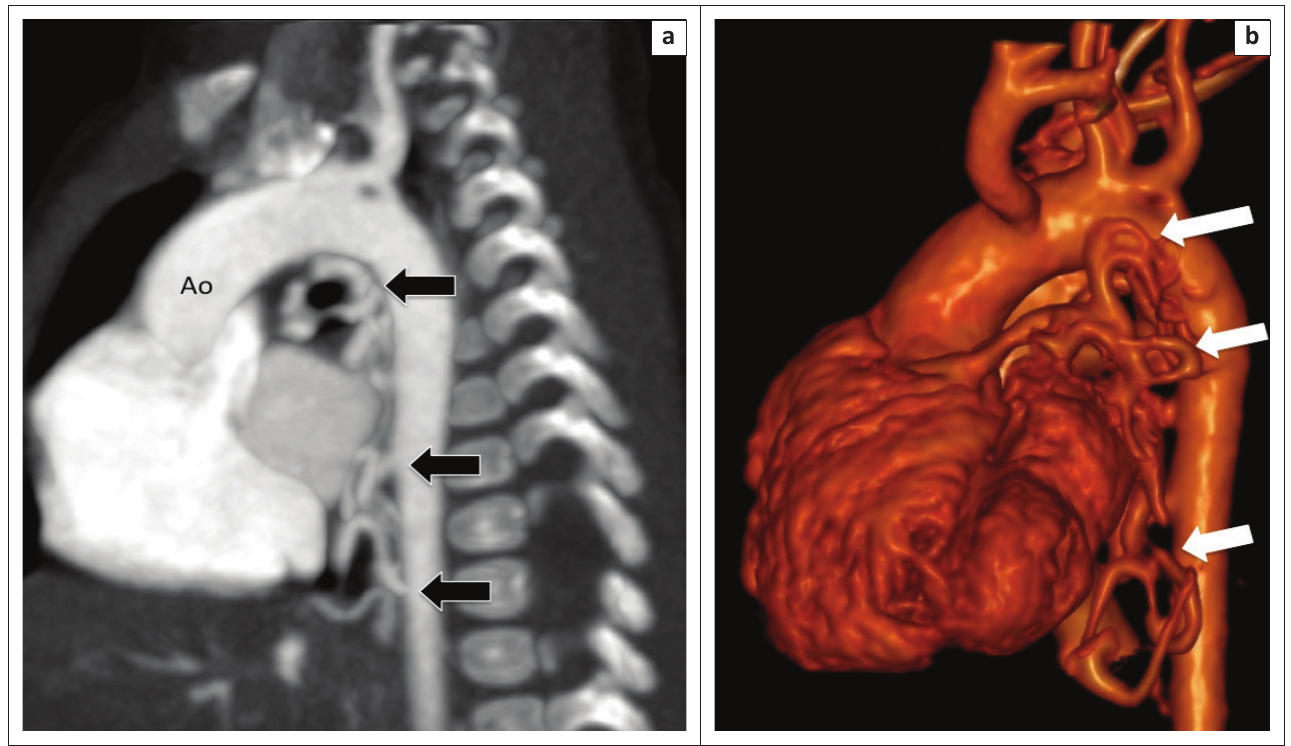
FIGURE 5: Numerous MAPCAs (arrows) arise from the descending thoracic aorta and join the left upper lobe pulmonary artery prior to its first order bifurcation. Sagittal thick-section MIP (a). Volume rendered CTA (b) in the same